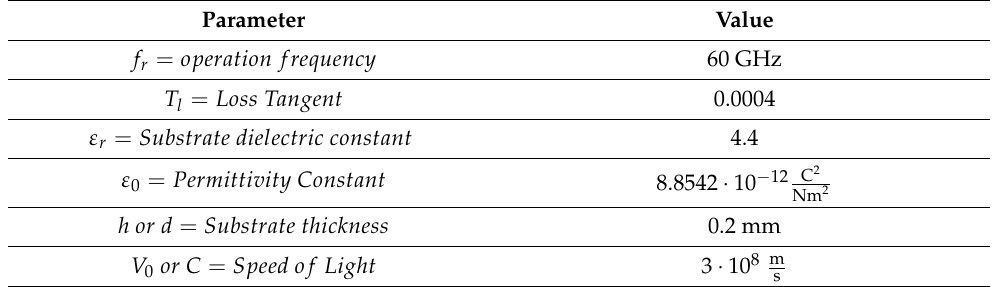
Table 1. FR-4 substrate parameters.